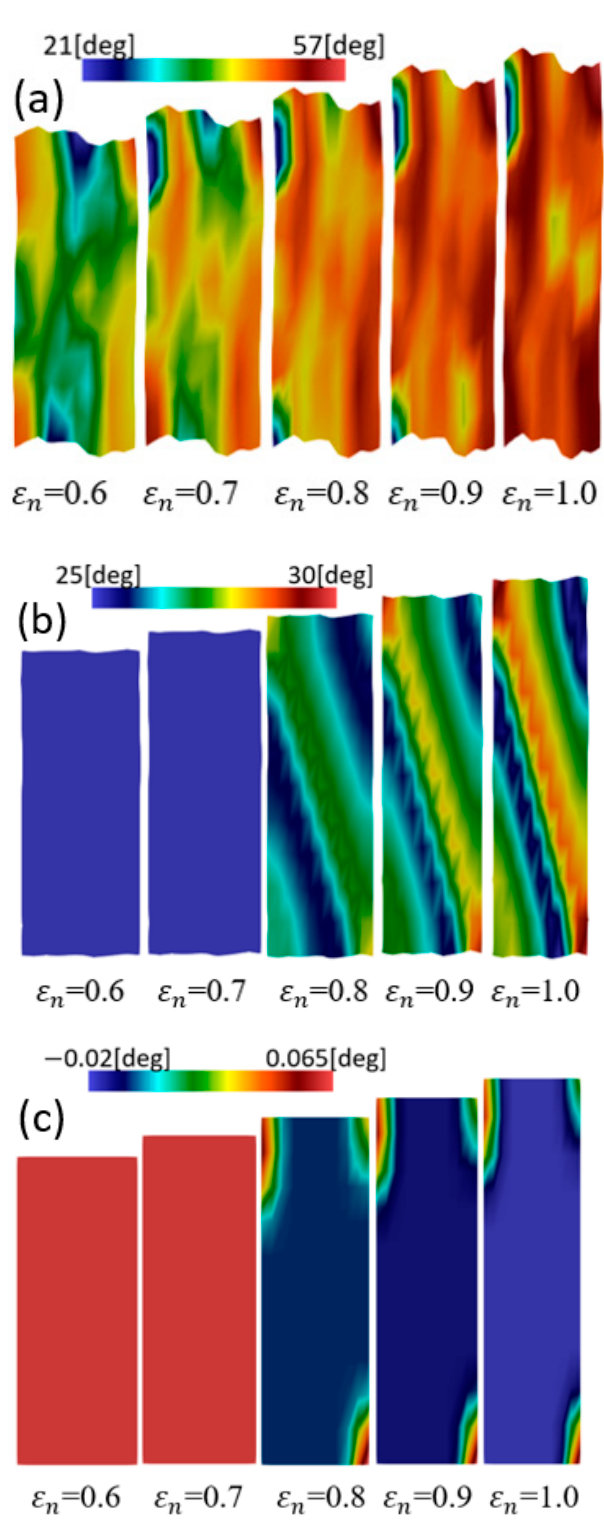
Figure 9. The distribution of the rotation angle of the transformation variant of single crystal TRIP steel with initial crystallographic orientations of ( a ) ∅ = 30 ° , ( b ) ∅ = 60 ° and ( c ) ∅ = 90 ° .